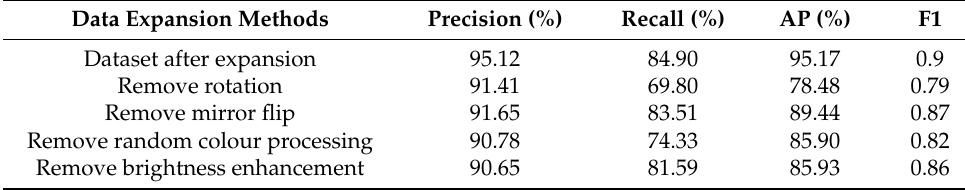
Figure 9. Image detection results of five algorithms on sugarcane stem nodes in different time periods. Table 7. The recognition effect of different data expansion